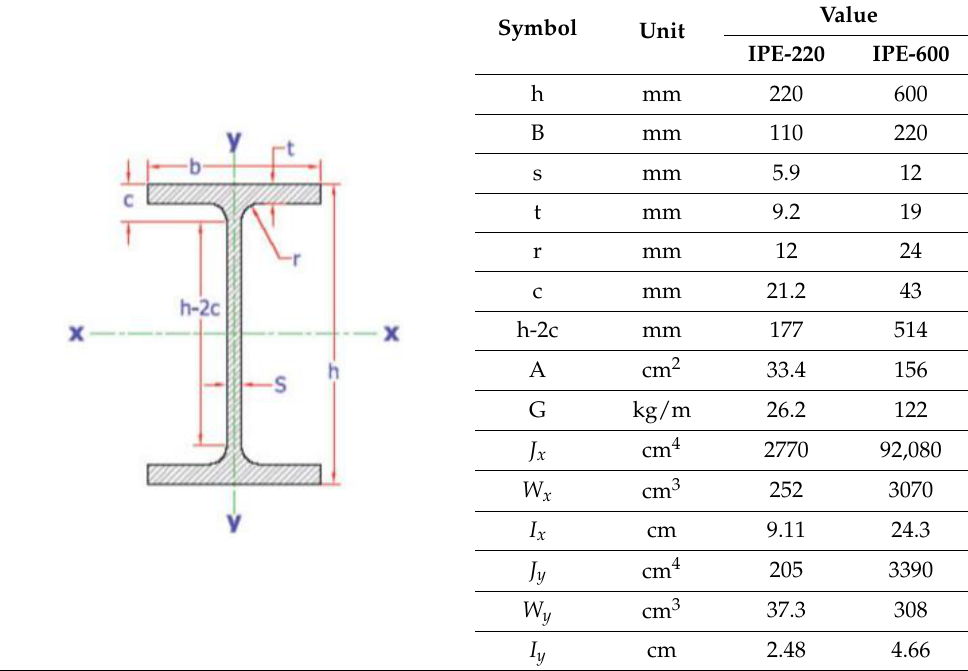
Table 1. Dimensional specifications and geometrical parameters of piles used in the current study.